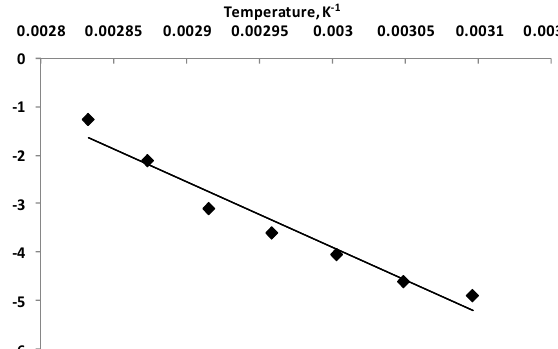
Fig. 2. Arrhenius plot for the thermal inactivation of PME crude extract in 20 mM citrate buffer at pH 7.0